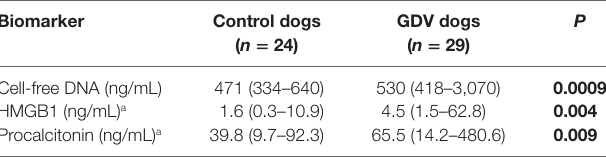
TaBle 1 | Concentrations of measured inflammatory biomarkers in dogs with GDV compared to healthy